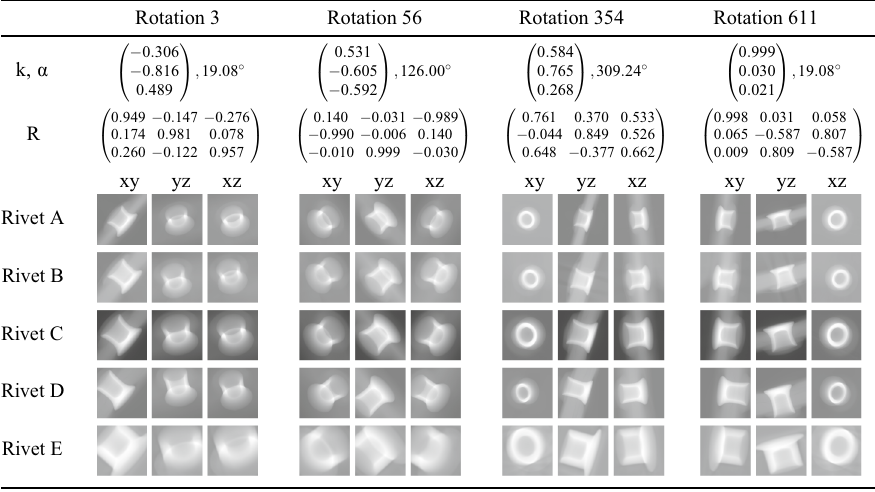
Angles were rounded to two decimal places. The influence of this rounding on the angle is assumed to be negligible. Matrix- and vector-related quantities, however, were rounded to three decimal places. This is for ensuring the possibility of quantifying the